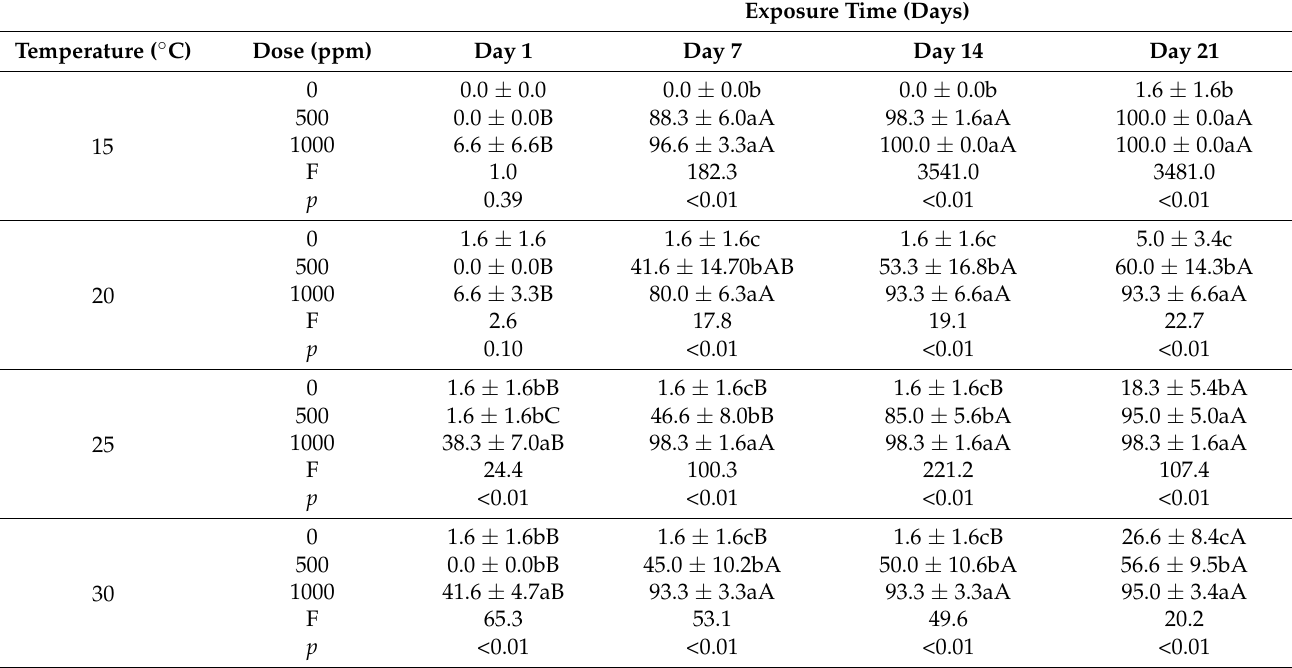
Table 3. Mean mortality (% ± SE) of C. ferrugineus adults exposed for 1, 7, 14, and 21 days to wheat treated with three different doses of diatomaceous earth (0, 500, and 1000 ppm) and four different temperatures (15, 20, 25, and 30 ◦ C), at 75%